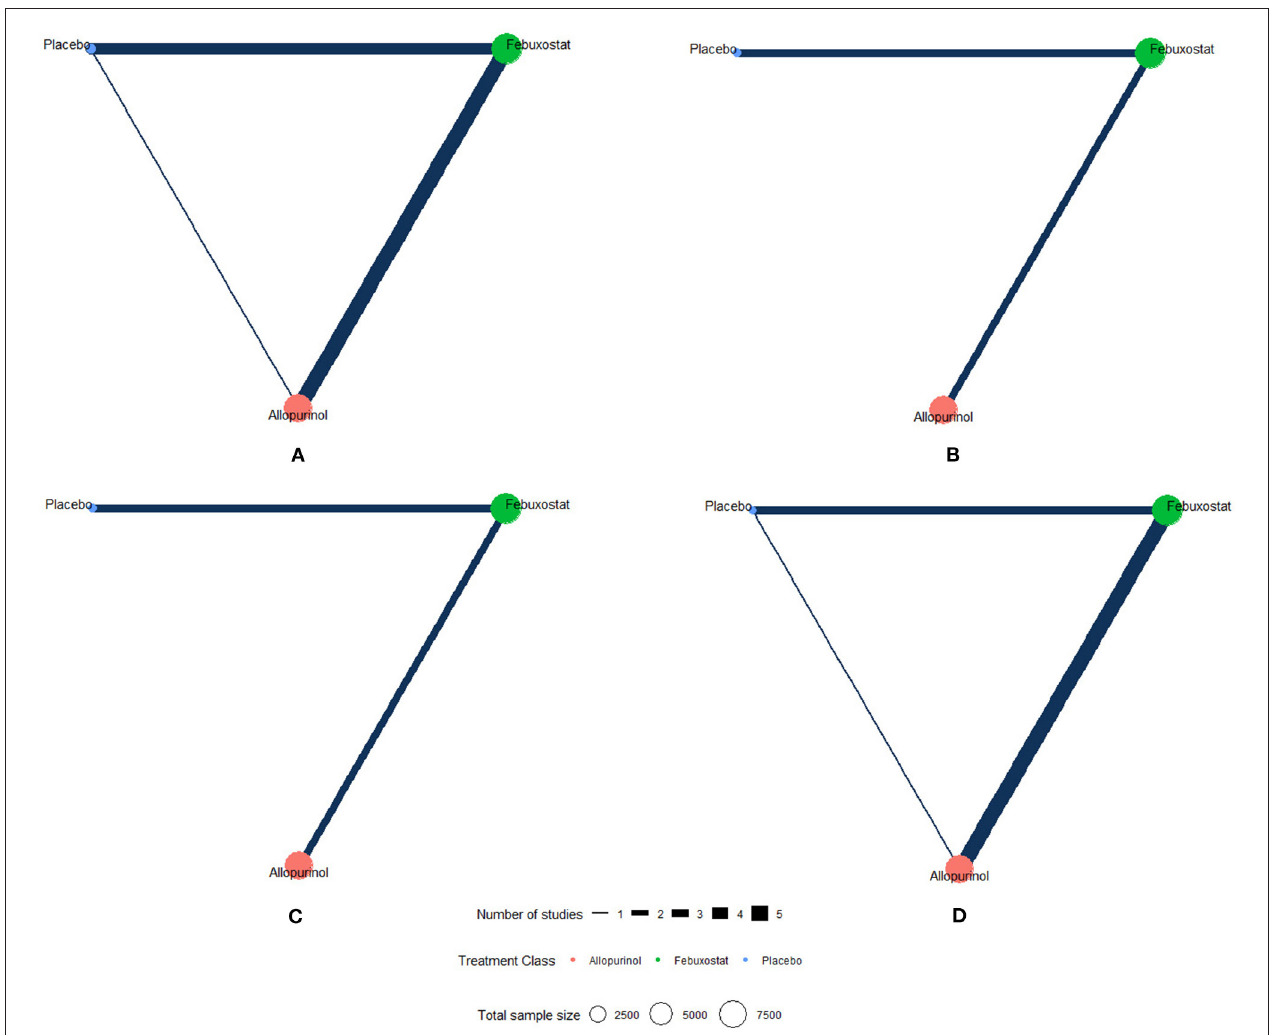
FIGURE 2 | Network plots of each outcome. The network of eligible studies for different outcomes. Different color of nodes represents different treatment. The node sizes correspond to the number of participants that investigated the treatments. The thickness of edges represents the number of trials. A lack of line indicates that there were no head-to-head trials between two treatments for this outcome. (A) MACE (major adverse cardiovascular events), (B) non-fatal MI (myocardial infarction), (C) non-fatal stroke, and (D) cardiovascular